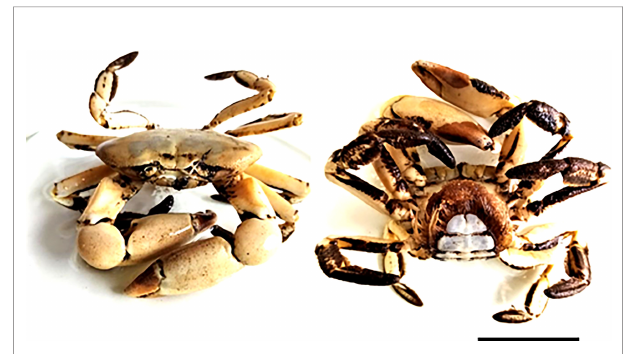
FIGURE 2 | Brooding crabs of Segonzacia mesatlantica in both ventral and dorsal view. Scale bars = 15 mm.